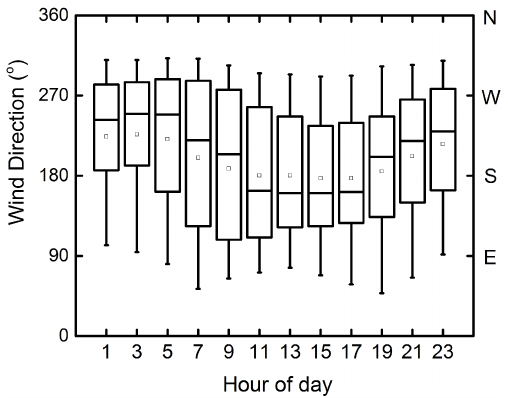
Figure 3. Wind direction as a function of time of day as measured at Kenosha harbor from April to November of 2009. Box plots show mean ( (cid:3) ), median (centerline), 25–75% (box) and 10–90%